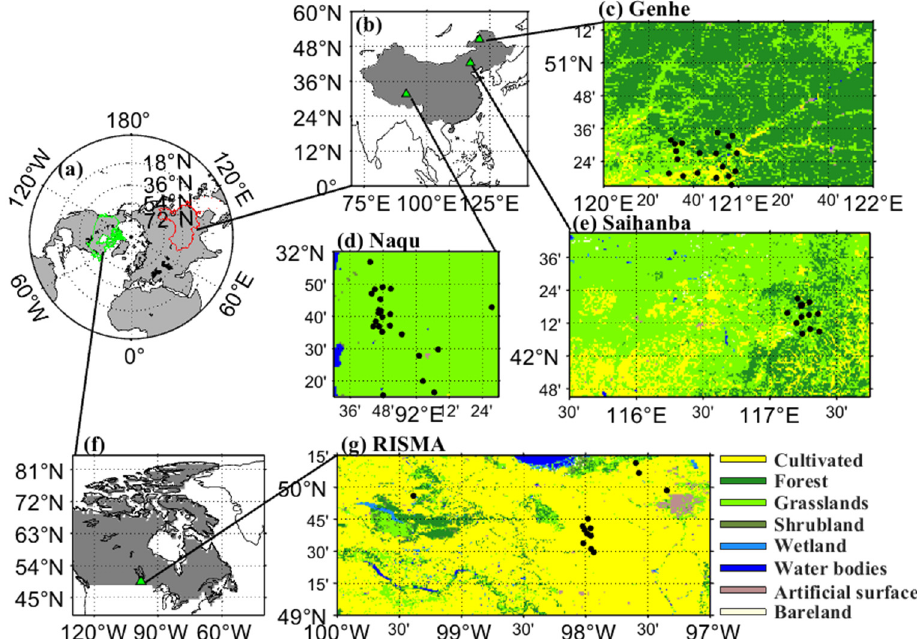
Figure 1. Study area in Northern Hemisphere ( a ). Land cover map and distribution of in situ sites over the Genhe watershed ( c ), Saihanba ( e ), and Naqu ( d ) in China ( b ), and the RISMA network ( g ) in Canada ( f ).